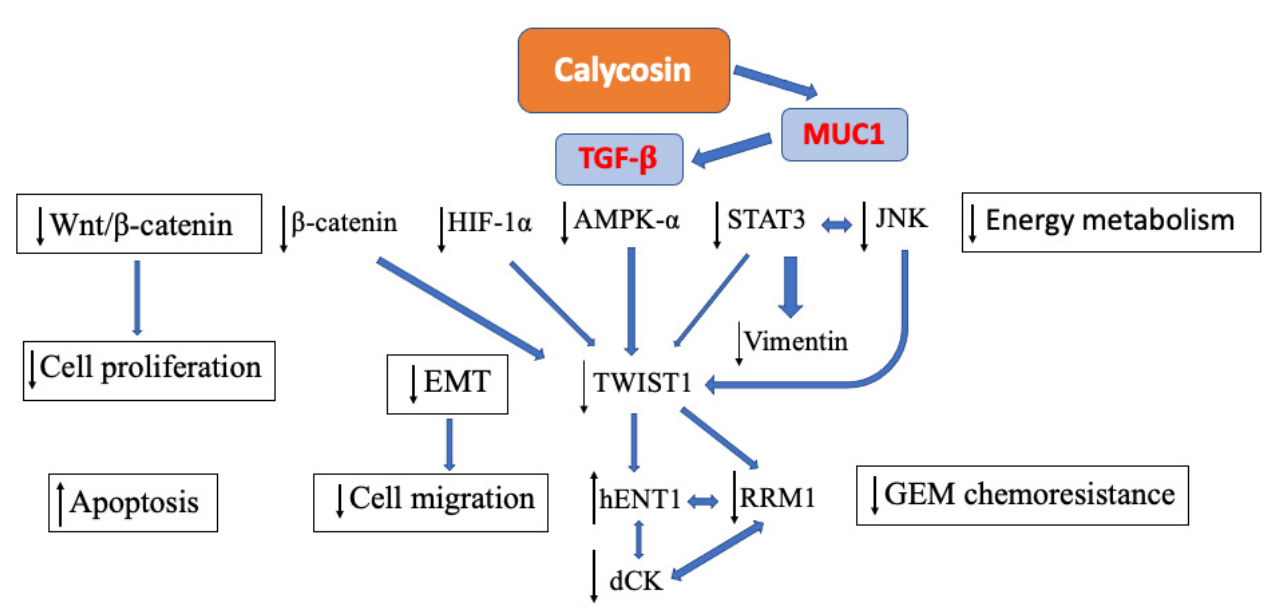
Figure 3. Calycosin inhibits pancreatic ductal adenocarcinoma progression by the promotion of apoptosis, the inhibition of cell proliferation and cell migratory activities, the facilitation of metabolic regulation, and the restoration of chemosensitivity.